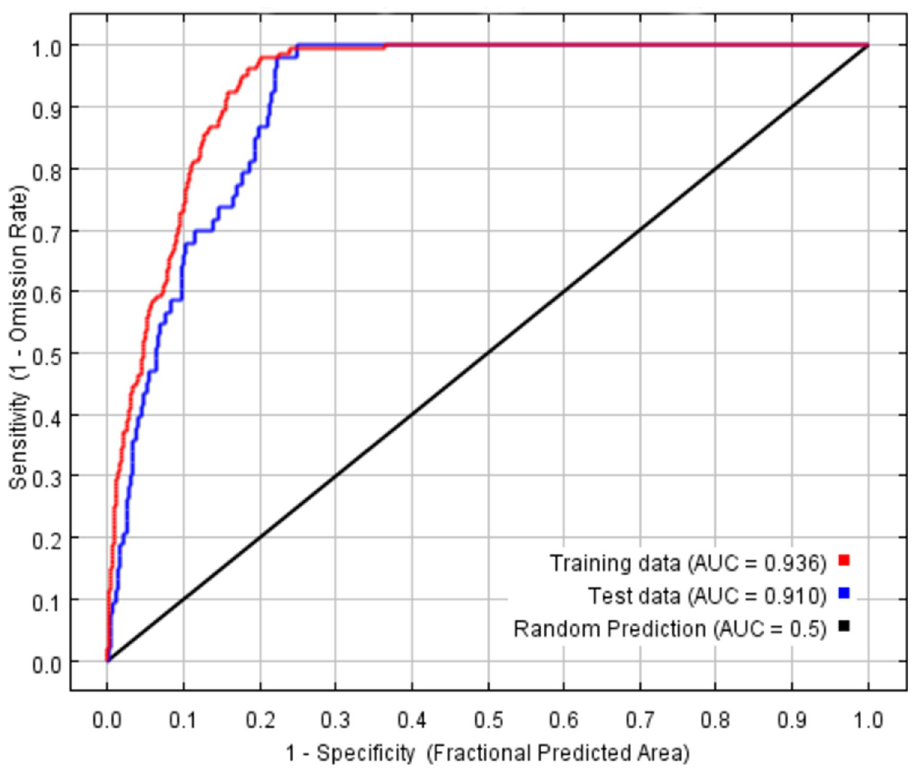
Fig 3. Receiver operating characteristic curve (ROC) of P . tatarinowii